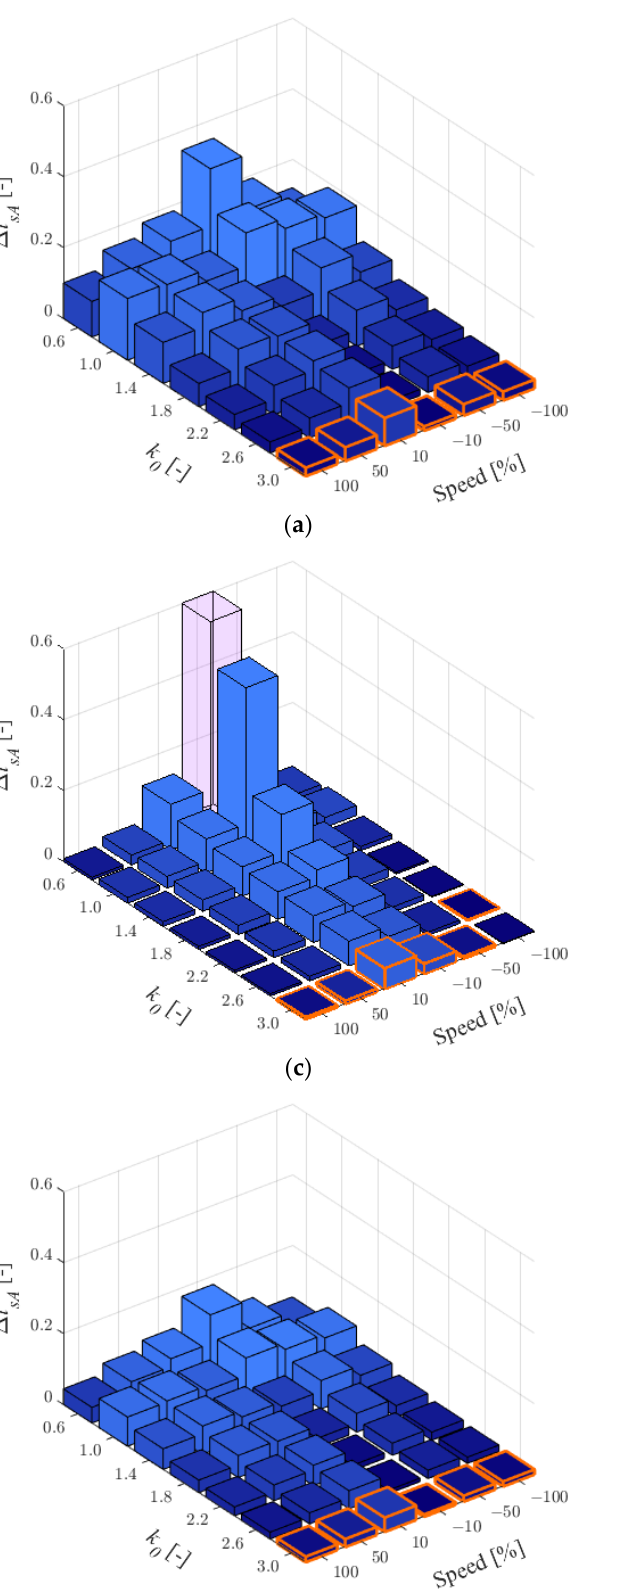
Figure 2. RMSE values for stator currents in phase A ( a , c , e ) and B ( b , d , f ) for r rIM = 1.5 r rN ( a , b ), r sIM = 1.5 r sN ( c , d ), l mIM = 1.5 l mN ( e , f ) and t Lref = 0.75 t LN , when both CSs are